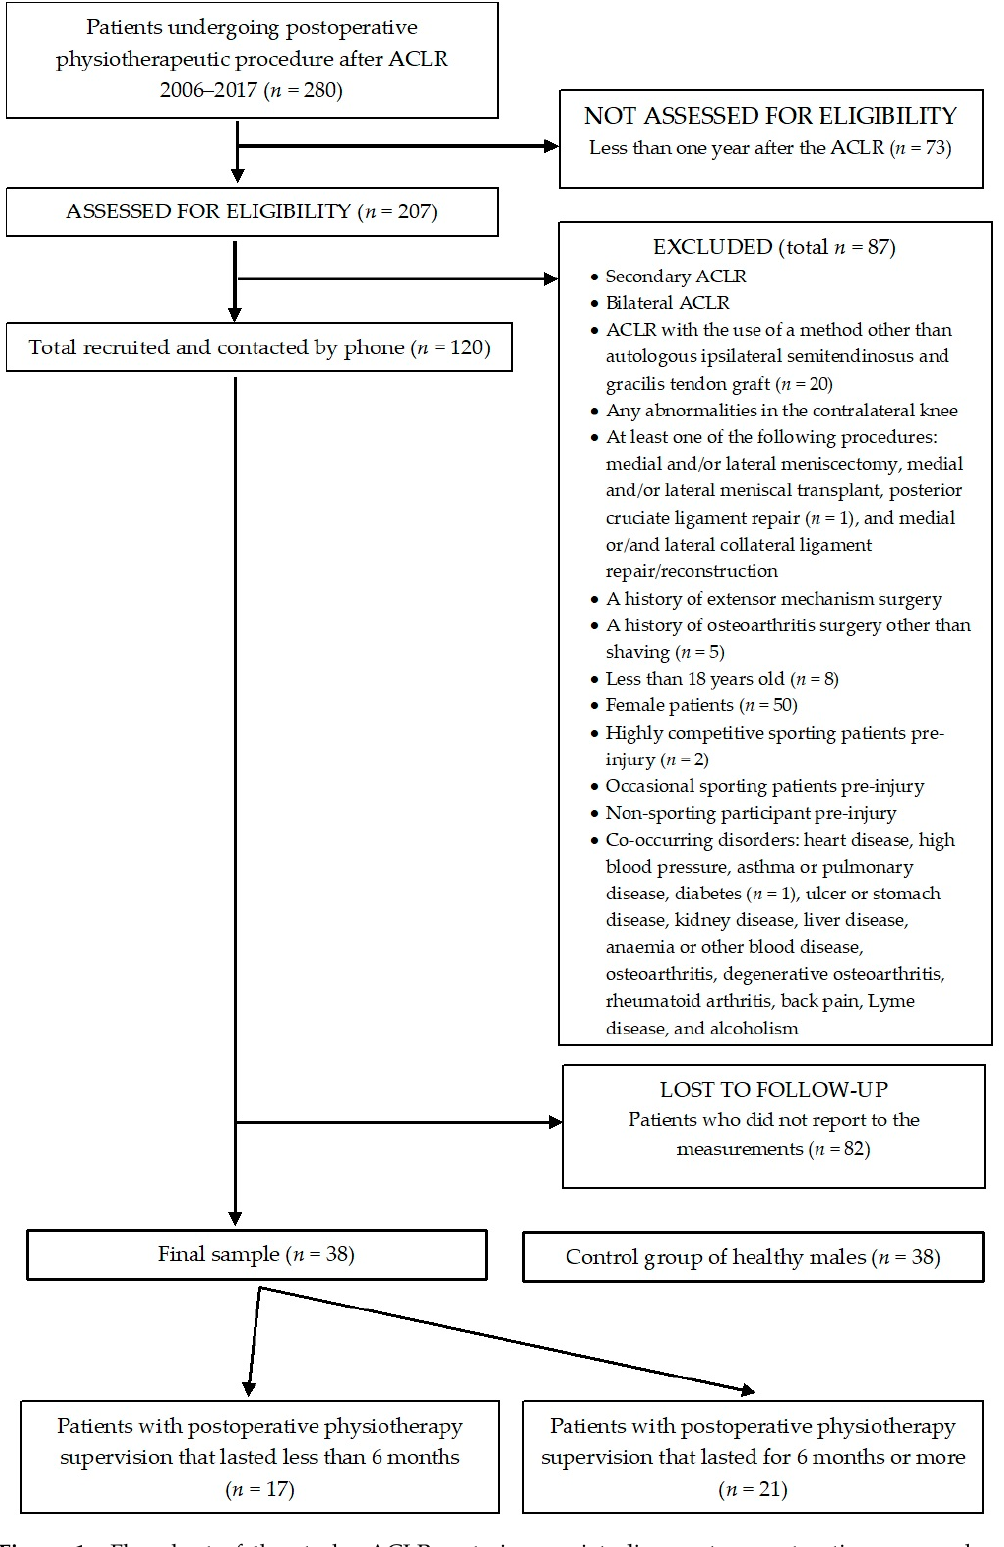
Figure 1. Flowchart of the study; ACLR: anterior cruciate ligament reconstruction; n , number of individuals.